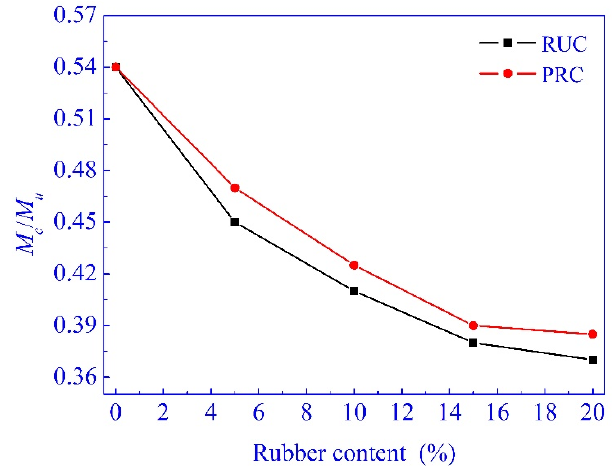
Figure 7. M c / M u of the